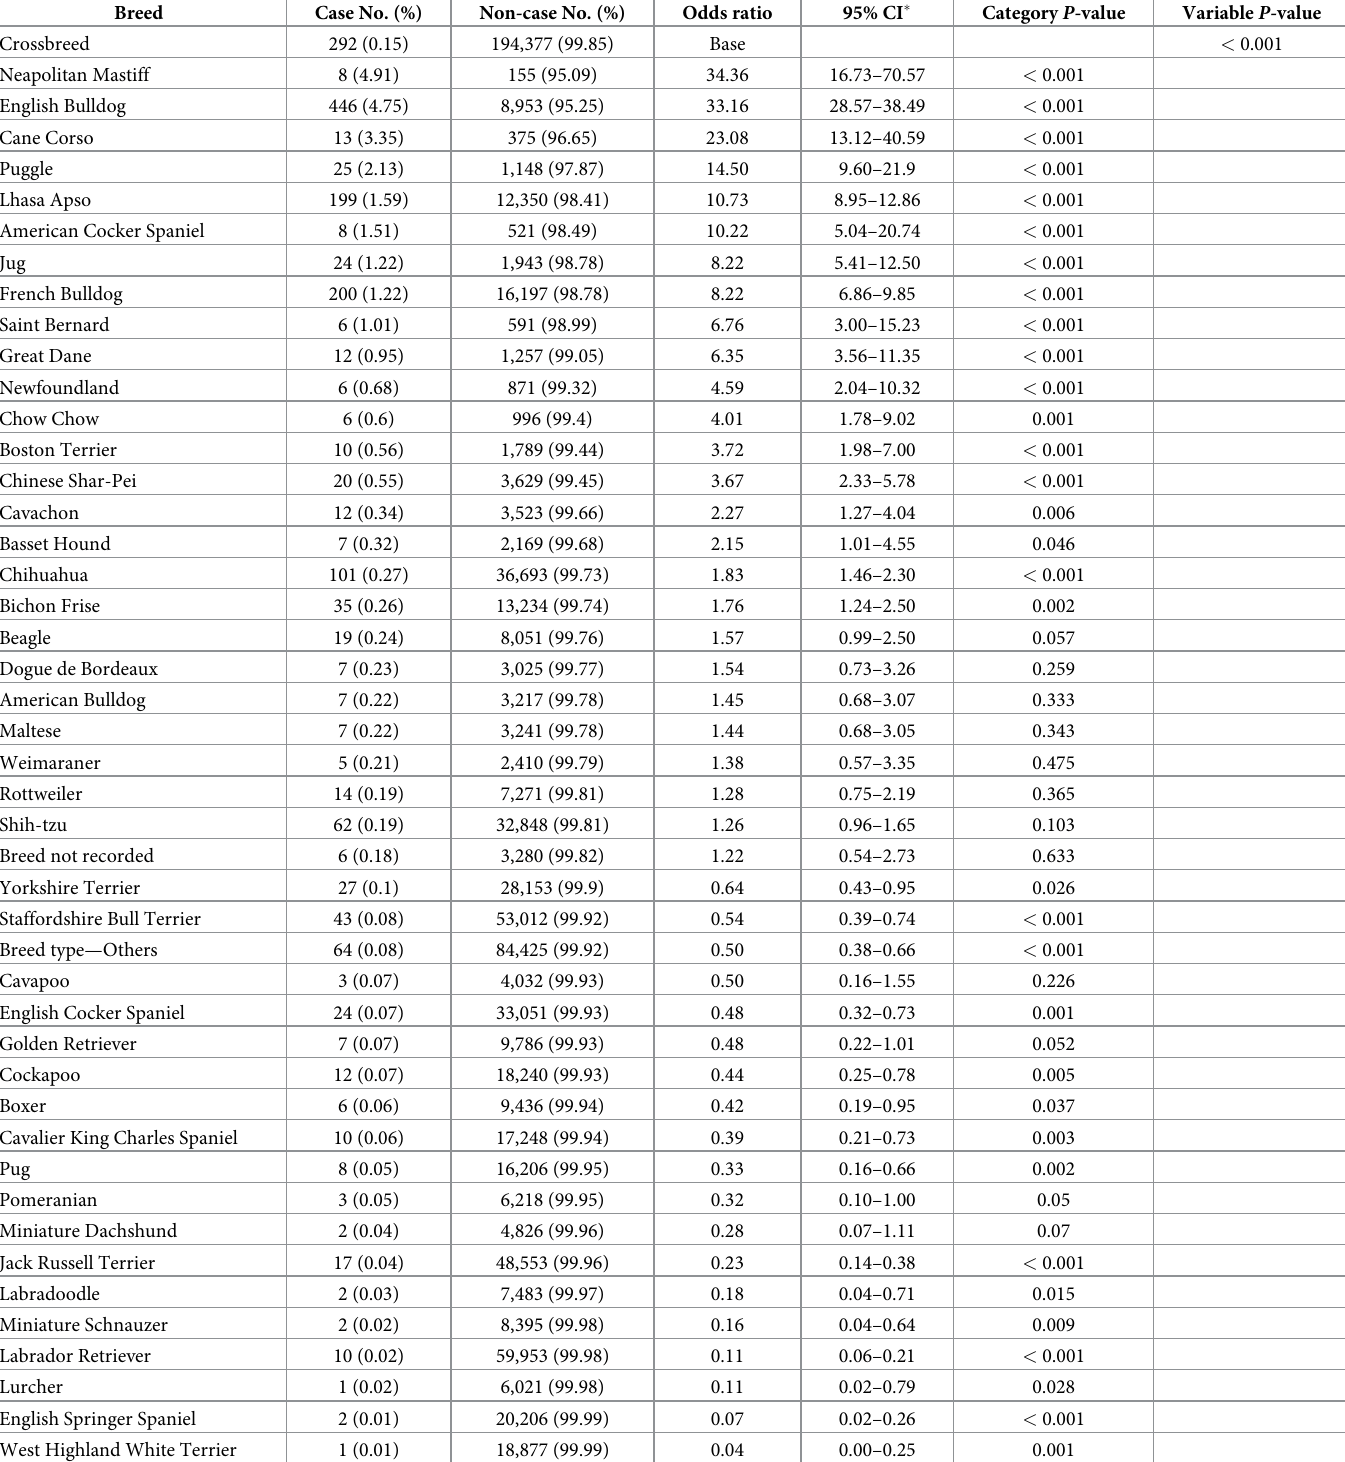
Table 1. Descriptive and univariable logistic regression results for breed as a risk factor for prolapsed nictitating membrane gland (PNMG) during 2016 in dogs under primary veterinary care in the VetCompass ™ Programme in the UK. Column percentages shown in